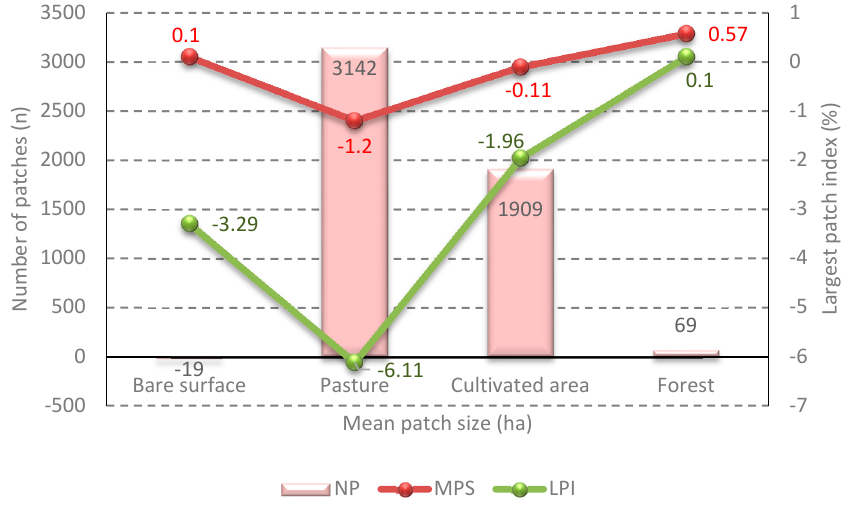
Figure 6. Gains and losses of NP, MPS and LPI of LULC by category in different time periods (1998–2015) in the lower part of the HSCZ.